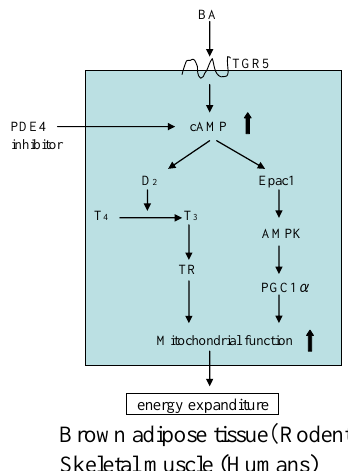
Figure 8. Mechanism of energy expenditure induced by bile acid (BA) via brown adipose tissue or skeletal muscle. TGR5: G protein-coupled receptor 5; D: Iodothyronine deiodinase; T: Thyroxine; TR: Thyroido hormone receptor; Epac 1: Exchange protein activated by cyclic AMP 1; AMPK: AMP-activated kinase; PGC 1á; Peroxisome proliferators-activated-receptor ã co-activator-1á.